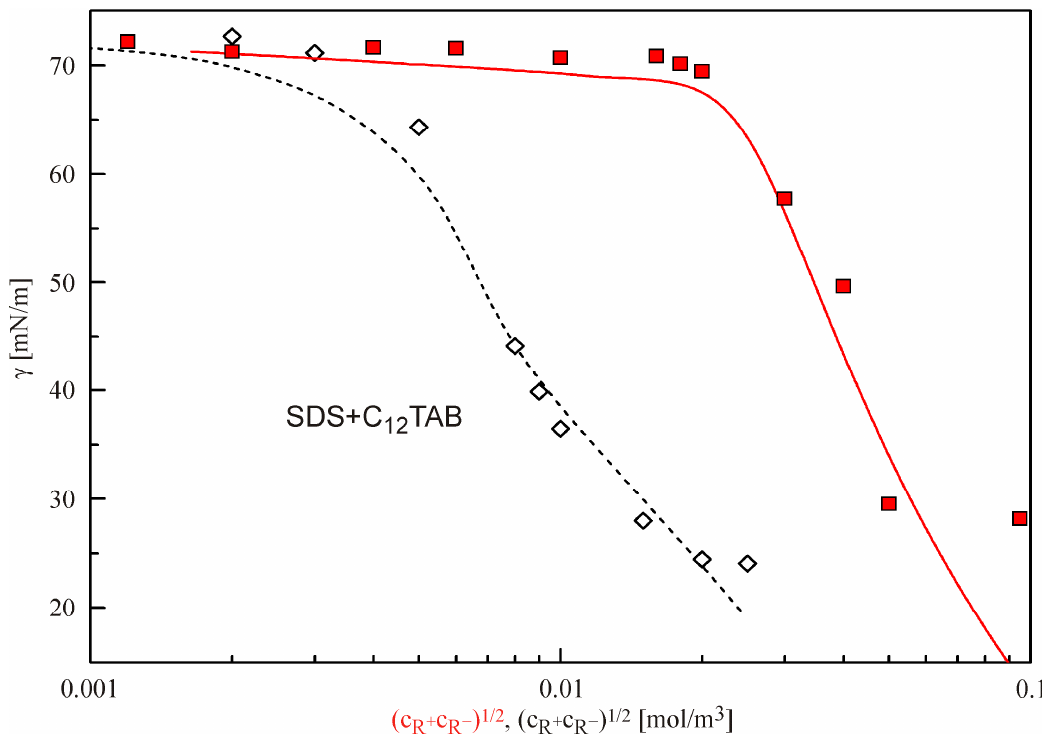
Figure 5. Equilibrium surface tension isotherms for aqueous equimolar C 12 TAB + SDS solutions plotted as a function of the ionic product concentration, as measured by bubble profile ( ) and drop profile analysis tensiometry ( ); the lines represent the fitting results as explained in the text.